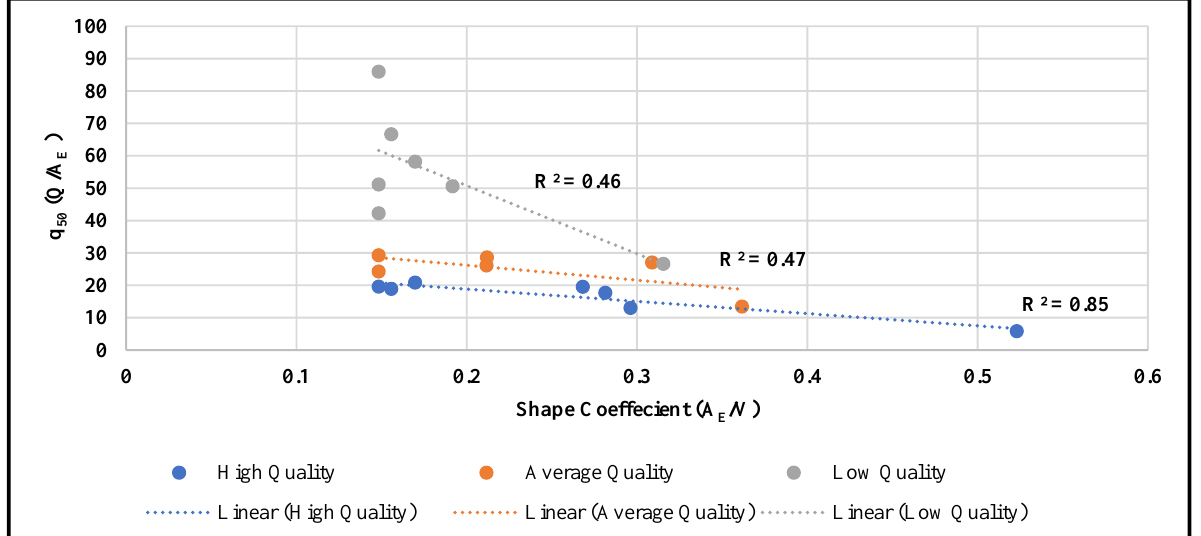
Figure 12. Linear correlation between q 50 and shape coefficient across the three different observed categories of observed fenestration quality.